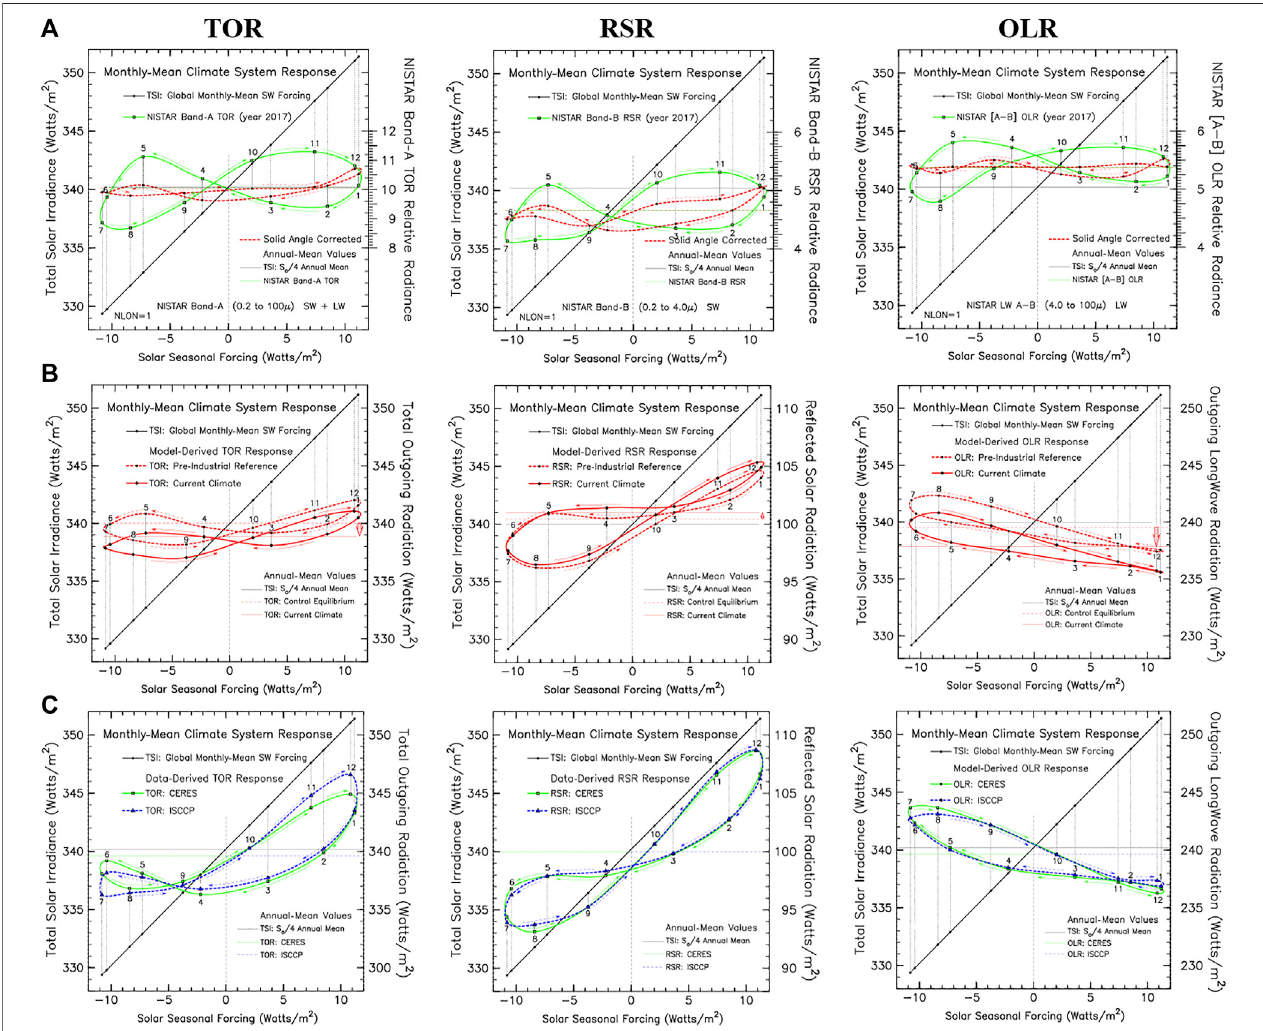
FIGURE 8 | (A) Seasonal NISTAR data for Total Outgoing Radiation (TOR), Re fl ected Solar Radiation (RSR), and Outgoing Longwave Radiation (OLR) in pinwheel format. The heavy green pinwheels are full-day (longitudinal) average Level 1B monthly-mean data. The red-dash curves represent the green pinwheel data but include inverse square Earth-Satellite distance correction. (B) Seasonal variability of global monthly-mean ModelE2 TOR, RSR, OLR pinwheels for pre-industrial (red dash) and current climate (solid red) conditions. (C) Seasonal variability of global monthly-mean CERES (green) and ISCCP (blue dash) pinwheels for TOR, RSR, and OLR.